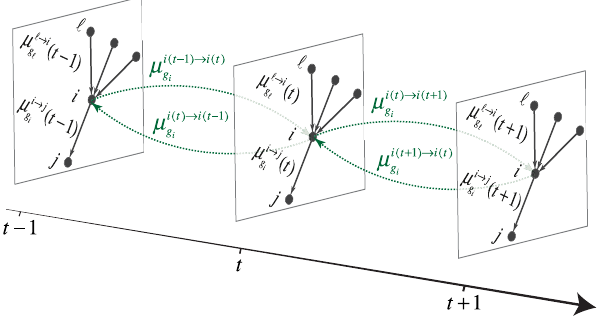
FIG. 1. A schematic representation of belief propagation messages [see Eqs. (5) and (6)] being passed along spatial and temporal edges in the spatiotemporal